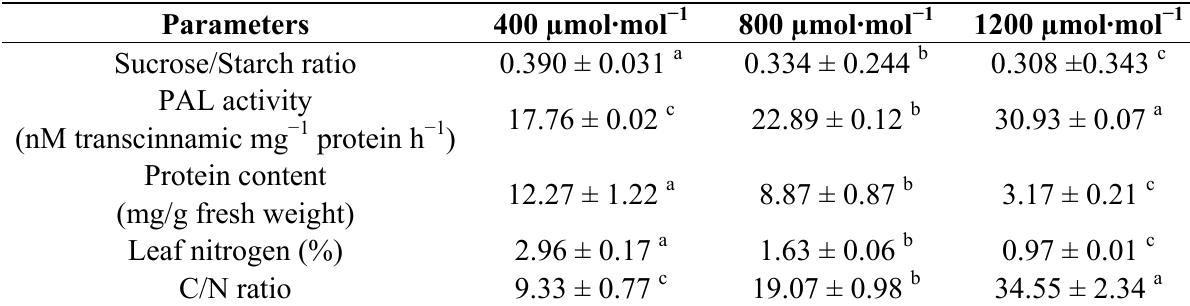
Table 4. Effects of different CO Elaeis guineensis